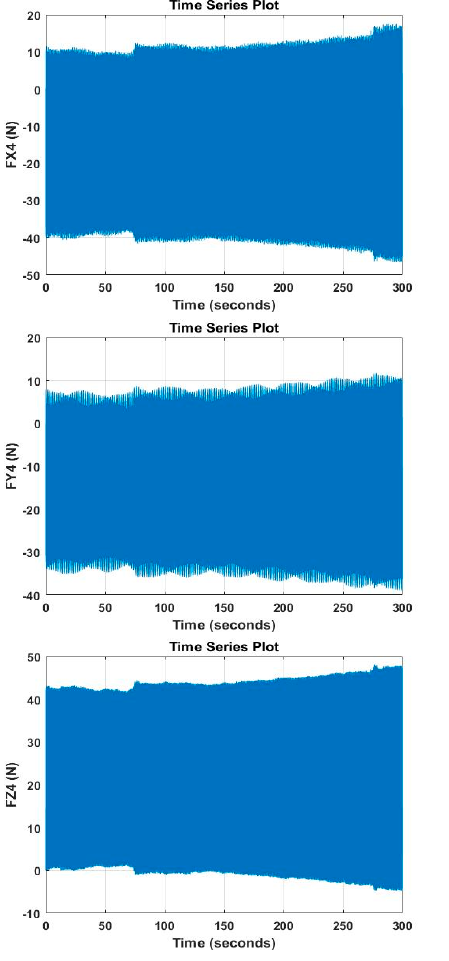
Table 2. Comparison of force transmission results from GUI for case I and case II.